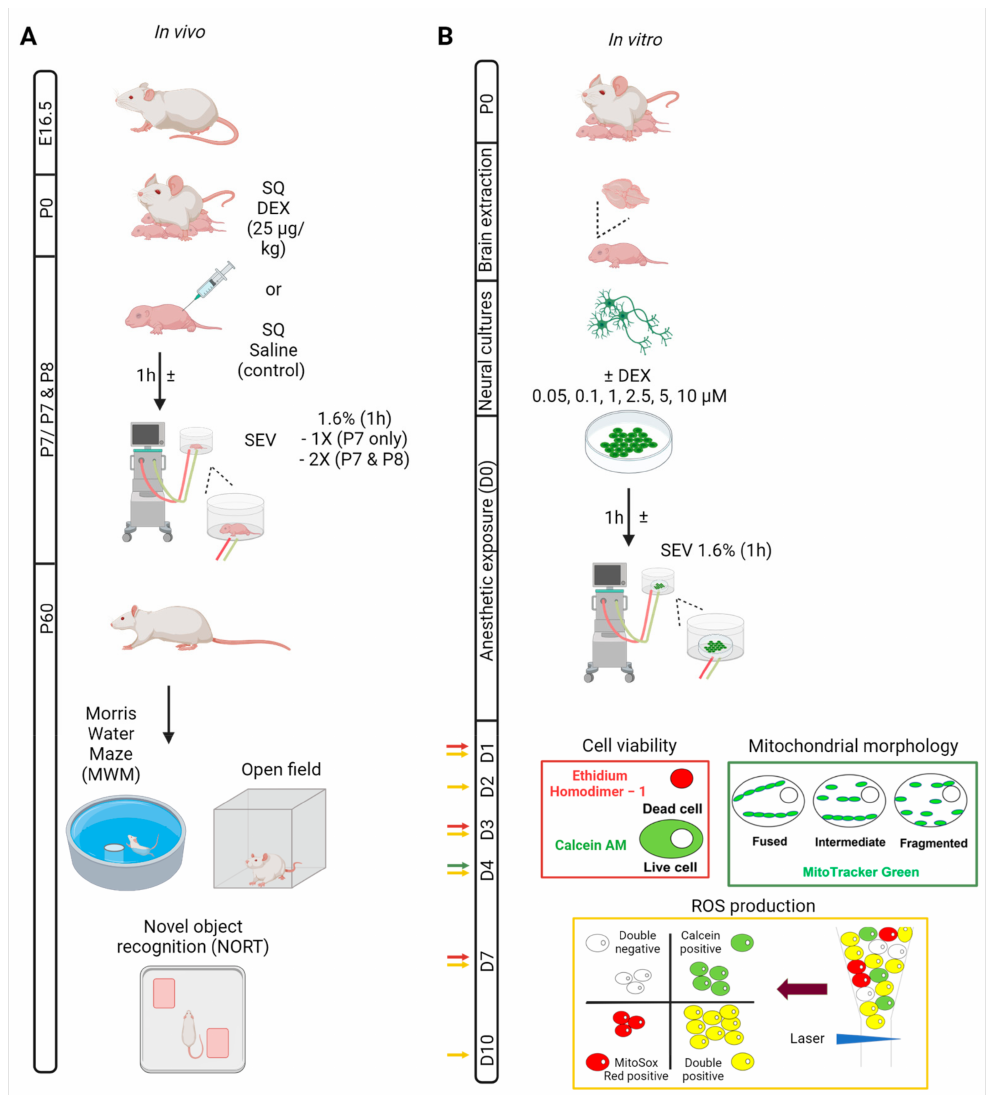
Figure 1. Schematic representation of experimental procedures. ( A ) In vivo procedure: pregnant rat arrives at E16.5 and pregnancy is monitored until P0, where pups are born. Pups are monitored until P7 when they are exposed to subcutaneous dexmedetomidine (using an equivalent volume of 0.1 mL of saline for the control animals) followed by 1.6% sevoflurane exposure for 1 h (single (P7)) or double exposure (P7 and P8) to analyze the effect on learning and memory in the adult animals (P60) using a batch of behavioural tests: (1) Morris Water Maze to assess spatial memory; (2) open field test to analyze anxiety, locomotor behaviour and willingness to explore; and (3) novel object recognition memory test to assess both recognition and spatial memory. ( B ) In vitro procedure: